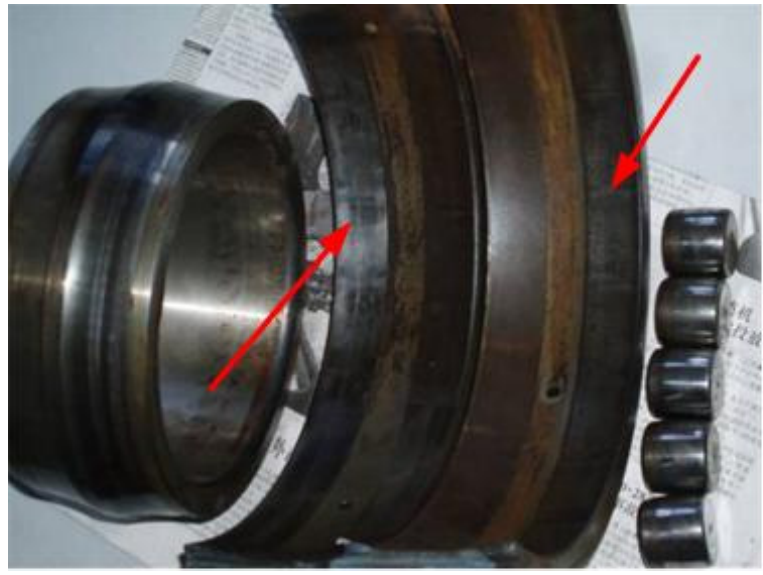
Figure 11. Picture of bearing components after test (outer race defect in bearing).